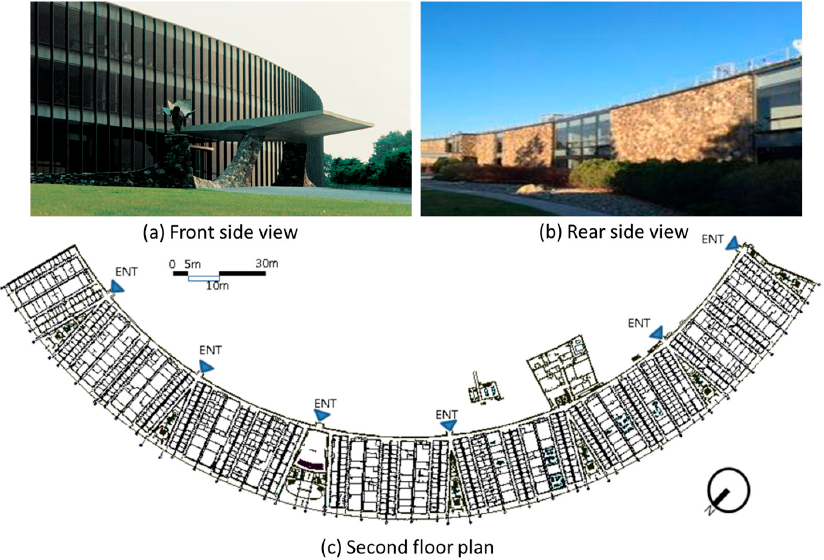
Figure 1. Features of the target building.